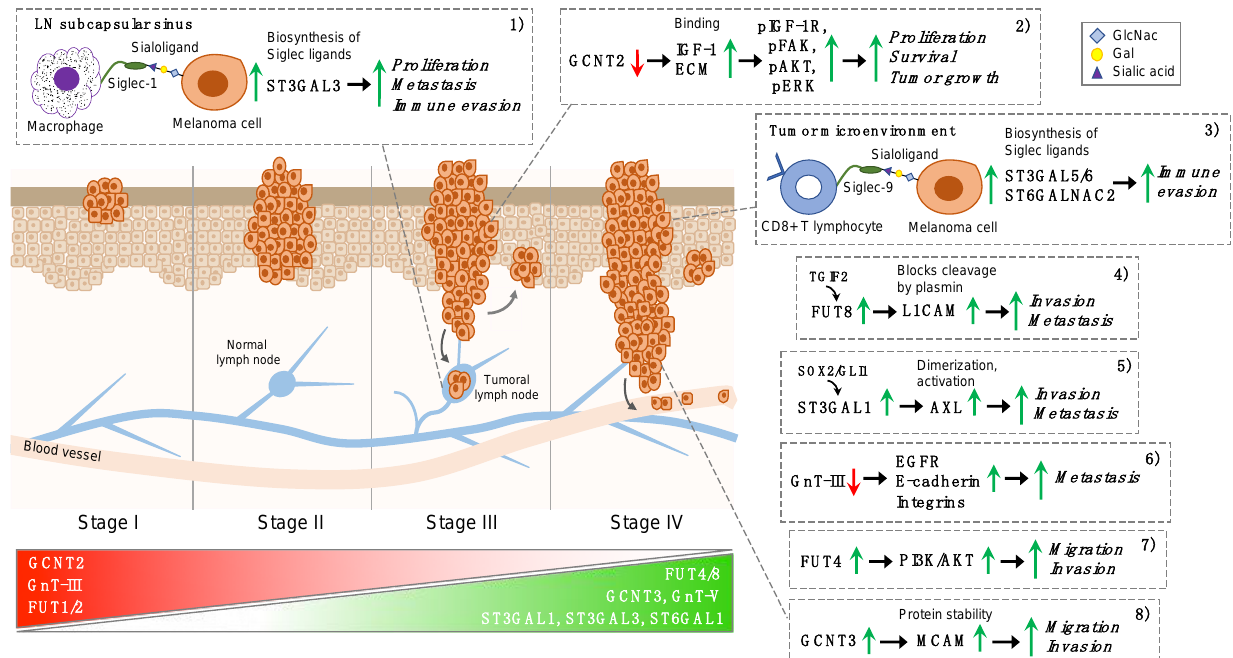
Figure 1. Glycosyltransferases as emerging effectors of melanoma progression. Schematic representation of selected glycosyltransferases and their role in the different stages of melanoma progression, based on the American Joint Committee on Cancer (AJCC) staging system. Stage I melanoma is no more than 1 mm thick; stage II extends beyond the epidermis into the thick dermis layer of the skin; stage III has metastasized to nearby lymph nodes, lymph vessels or skin; stage IV has metastasized to other places throughout the body, such as the brain, lungs or liver. Expression levels of FUT1/2, GCNT2 and GnT-III are high in early-stage and diminish during melanoma progression, whereas expression of FUT4/8, GCNT3, GnT-V, ST3GAL1, ST3GAL3 and ST6GAL1 are higher in late-stage melanomas. Glycosyltransferases may promote